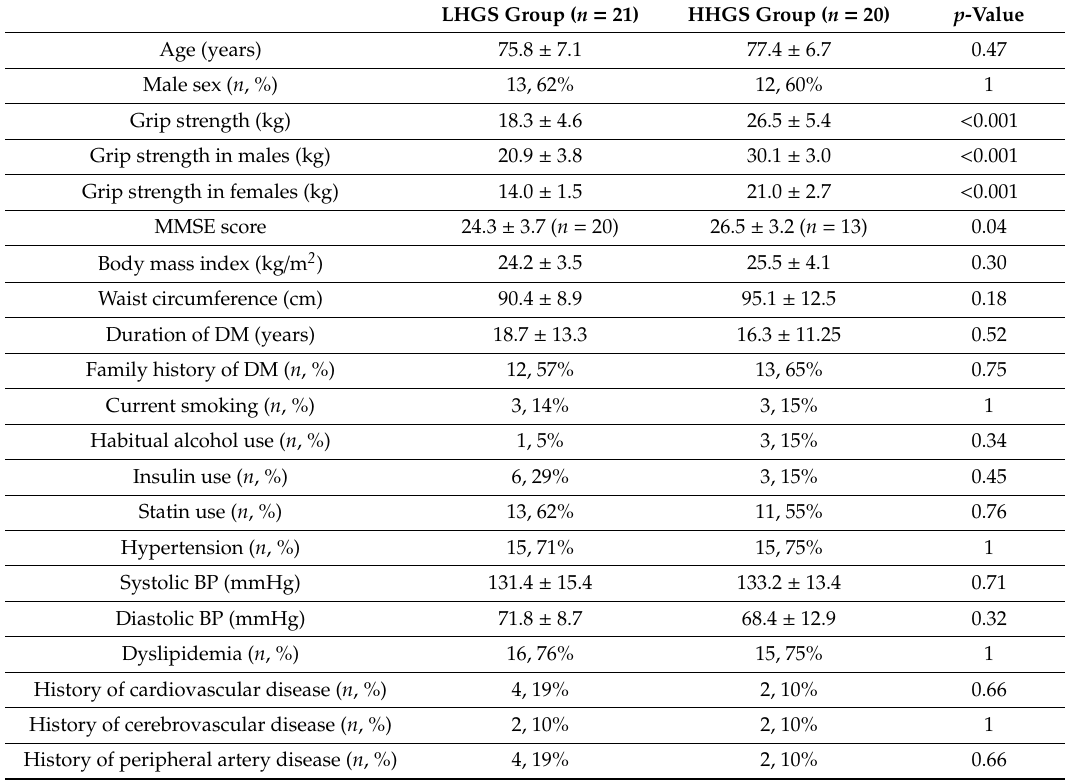
Table 1. Background